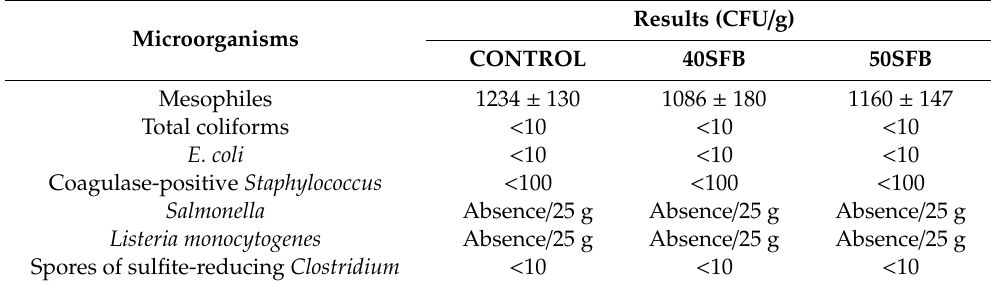
Table 4. Microbial counts in chicken